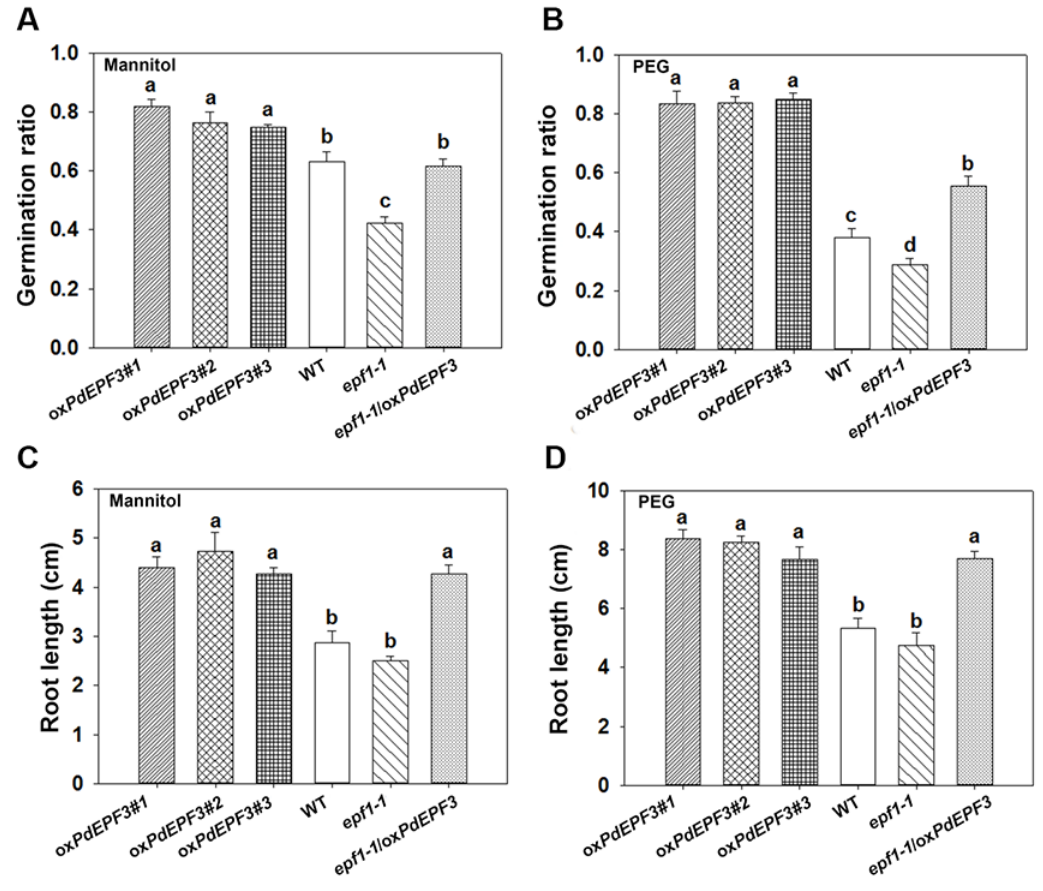
Fig. 4 Differences in the germination ratio and root length in Arabidopsis . ( A ) Germination rate under 1/2 MS + 200 mM mannitol treatment. ( B ) Germination rate under 1/2 MS +25 mM PEG6000 treatment. ( C ) Root length of 1/2 MS + 200 mM mannitol treatment. ( D ) Root length of 1/2 MS + 25 mM PEG6000 treatment. Data are means ± SE ( n = 6). Different letters indicate significant difference ( p <